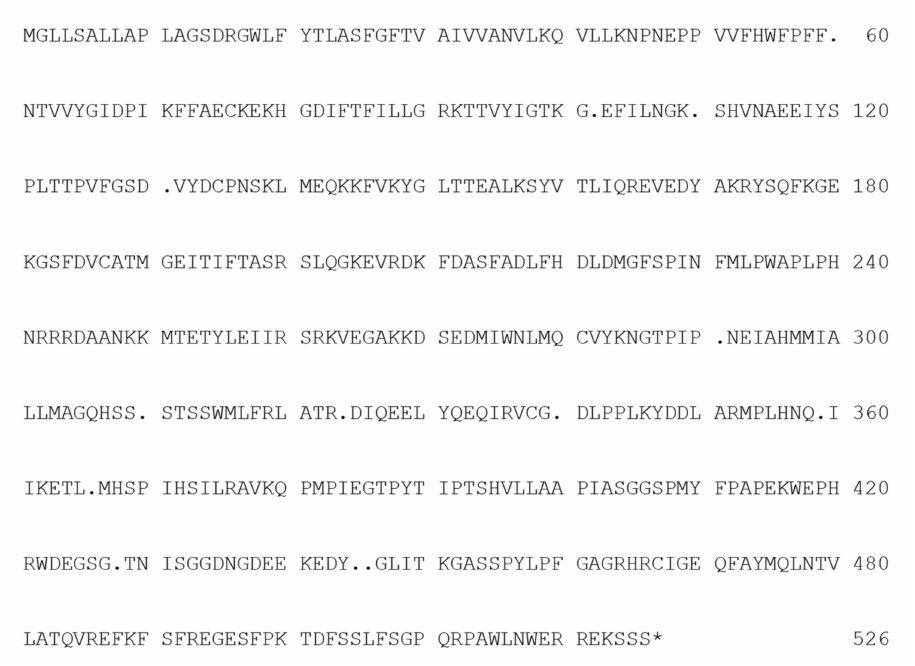
Figure 4. Translated deduced amino-acid sequence of Venturia nashicola CYP51 gene. Dots (.) indicate variants. Variants are summarized in Table 7. * Stop codon. Table 7. Amino-acid (AA) positions in CYP51 where mutations in the isolates of Venturia nashicola were sequenced. For each AA position the corresponding mutation and its eventual orthology are shown. SEPTTR: Zymoseptoria tritici ; ERYSGT: Blumeria graminis f. sp. tritici ; BRYSGH: Blumeria grami- nis f. sp. hordei ; UNCINE: Erysiphe necator ; MONIFG: Monilinia fructigena ; LEPTNO: Parastagonospora nodorum ; CERBE: Cercospora beticola . Table references: 1 Stammler et al. [31]; 2 Wyand and Brown